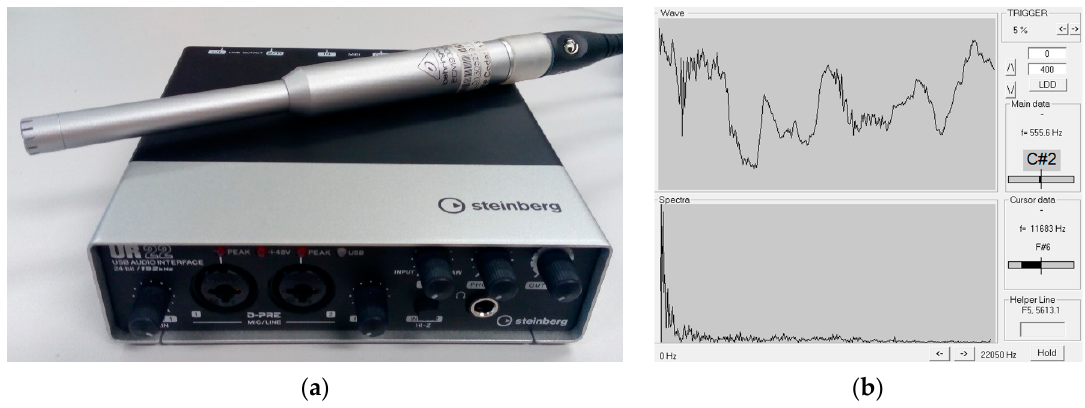
Figure 3. Photos of microphone ECM 8000 and amplifier UR22 MK2 ( a ) and record of the graphical interface of software of FFT analyzer ( b ).